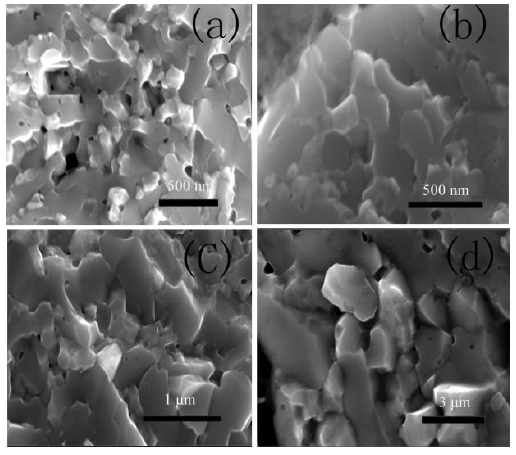
Figure 4. SEM results of as as-synthesized sample. ( a ) , ( b ), ( c ) and ( d ) show the SEM results of WB 2 synthesized at 5.2 GPa for 15 min ， with different temperatures of 1600 °C, 1700 °C, 1800 °C, 1900 °C, respectively.